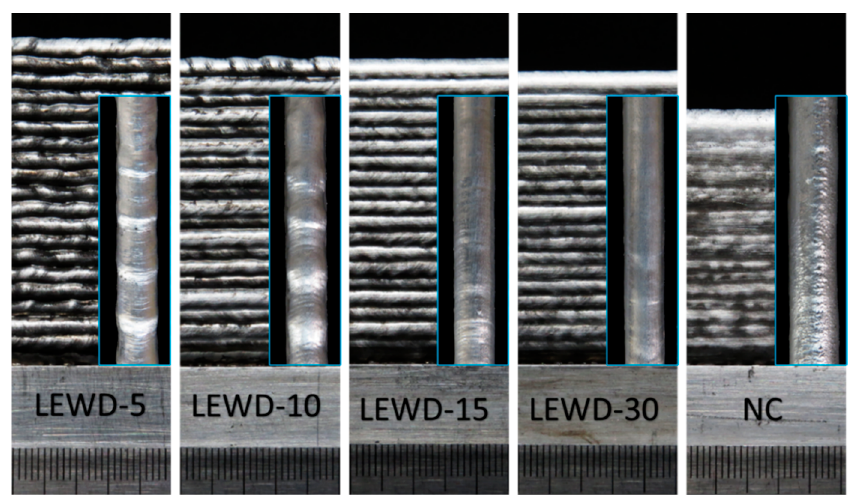
Figure 4. Effect of the LEWD parameter on the lateral and top superficial aspects of the 350 mm-long walls.